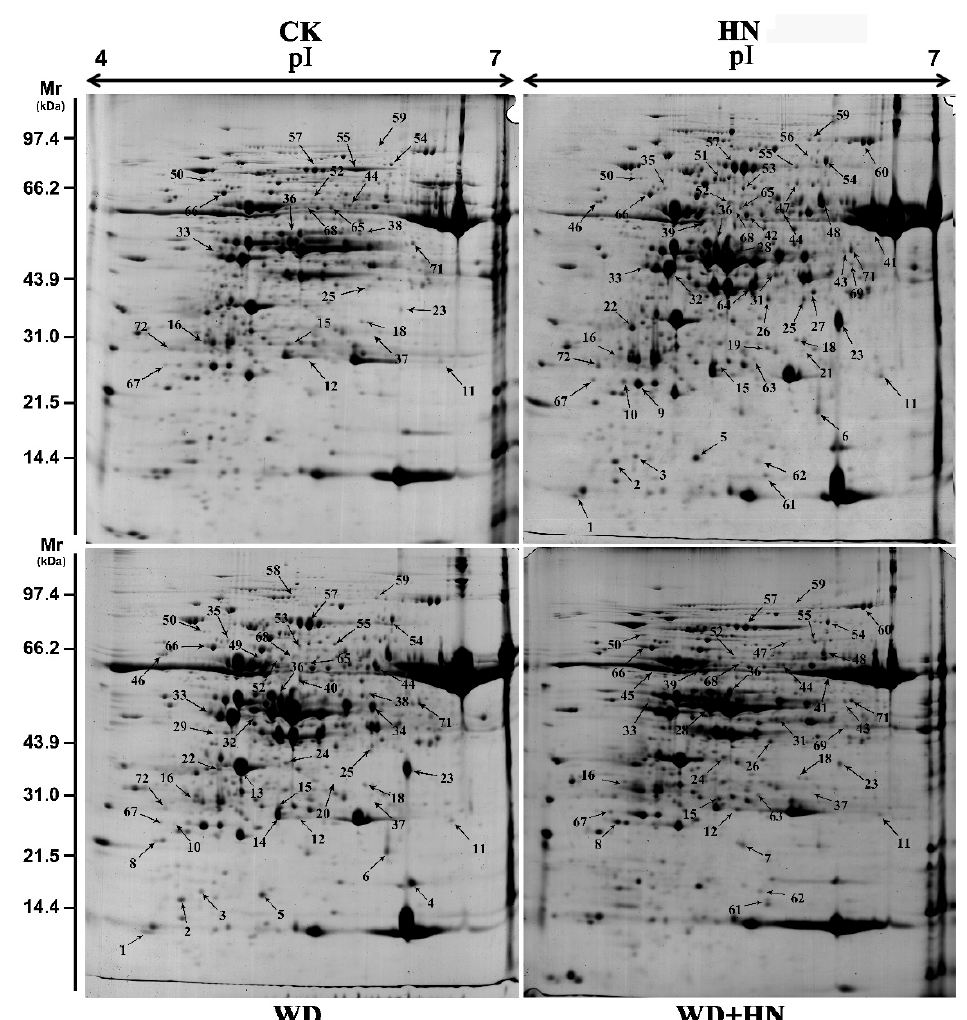
Figure 2. Images from two-dimensional gel analyses of wheat flag leaf proteomes under water-deficit, high-nitrogen (N) fertilization, and combined treatments. Samples were electrofocused on an 18-cm pH 4–7 linear Immobiline DryStrip gel and separated by sodium dodecyl sulfate–polyacrylamide gel electrophoresis on a 12% polyacrylamide gel. All differentially accumulated protein spots are numbered on the gel images. CK: regular watering and N fertilization; WD: no watering and regular N fertilization; HN: regular watering and high-N fertilization; WD+HN: no watering and high-N fertilization.